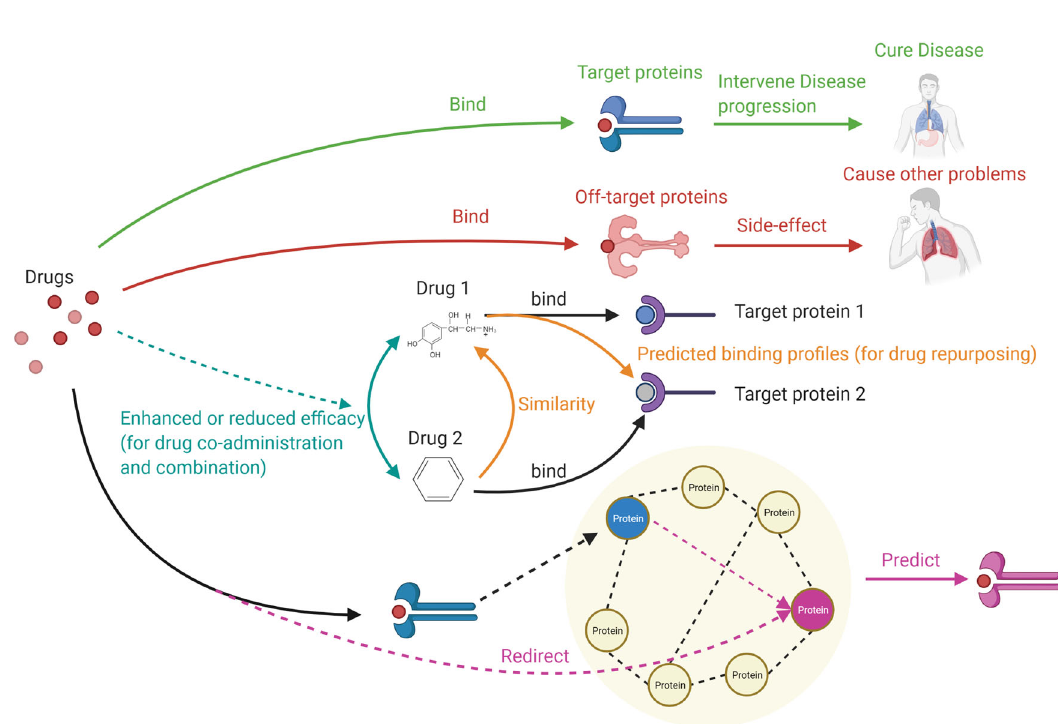
An example of constructing a static network